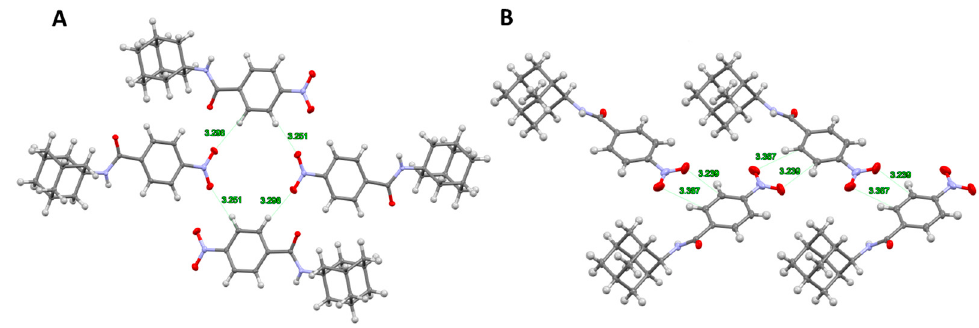
Figure 4. A partial packing plot of 18a ( A ) and 18b ( B ) showing a short contact between 4-NO 2 -group and H-atoms neighboring molecules.